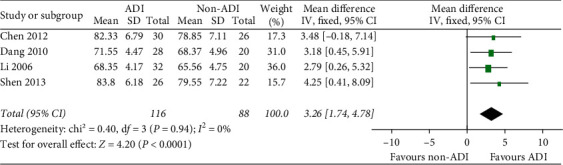
ADI improved the KPS score in advanced BC patients as an add-on therapy (MD = 3.26, 95% CI 1.74–4.78; chi2 = 0.4, P=0.94; I2 = 0%).